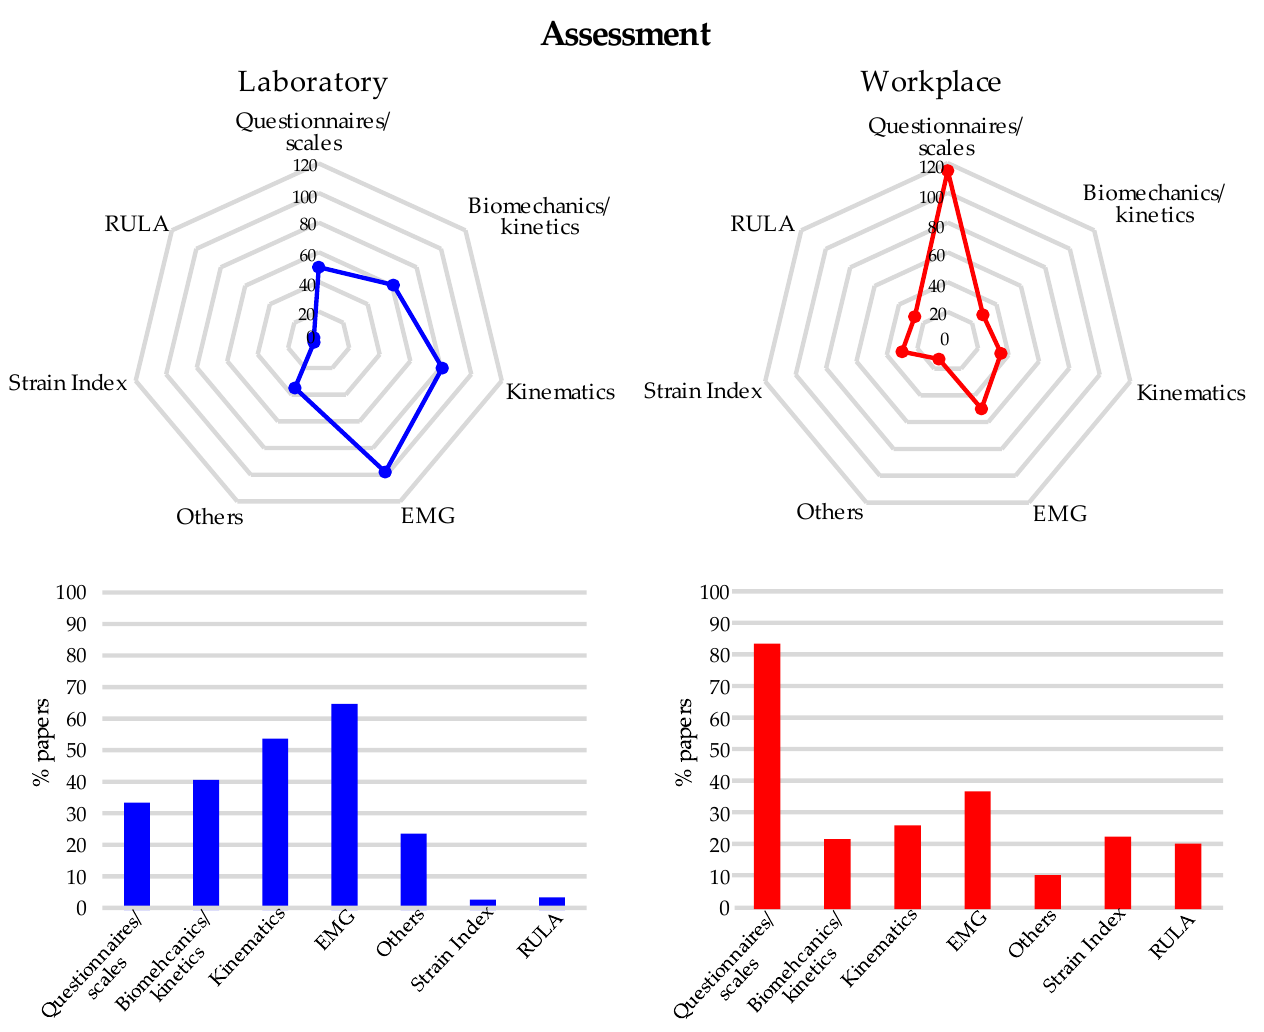
Figure 12. Assessment methods used in the considered studies. Some studies used more than one assessment (overall percentage could exceed 100%). In the upper panel, the number of studies that employed the considered assessment methods is reported for both laboratory (( left panel ), in blue) and workplace settings (( right panel ), in red). In the lower panel, the percentages of papers employing the assessment methods are shown in blue for laboratory and in red for workplace scenarios.